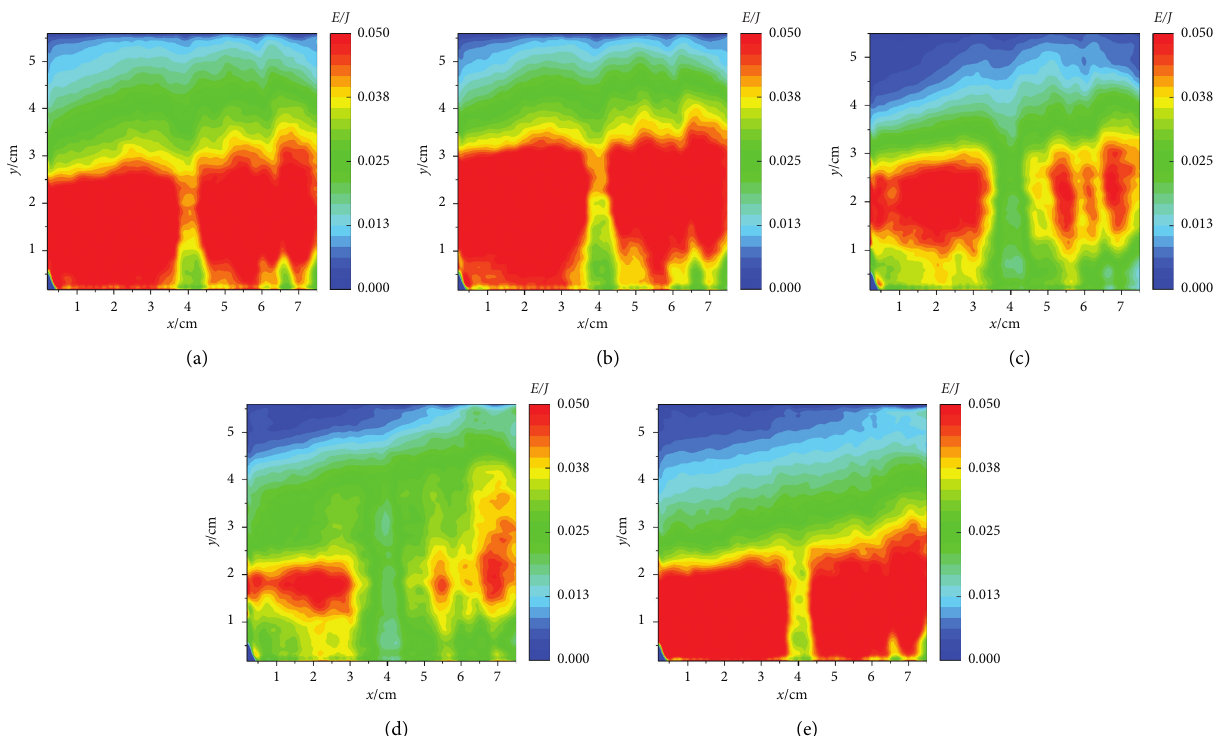
Figure 17: The distribution of the kinetic energy in different working conditions. (a) H25-1, (b) H25-1.2, (c) H25-1.5 (D252), (d) D251, and (e) D253.